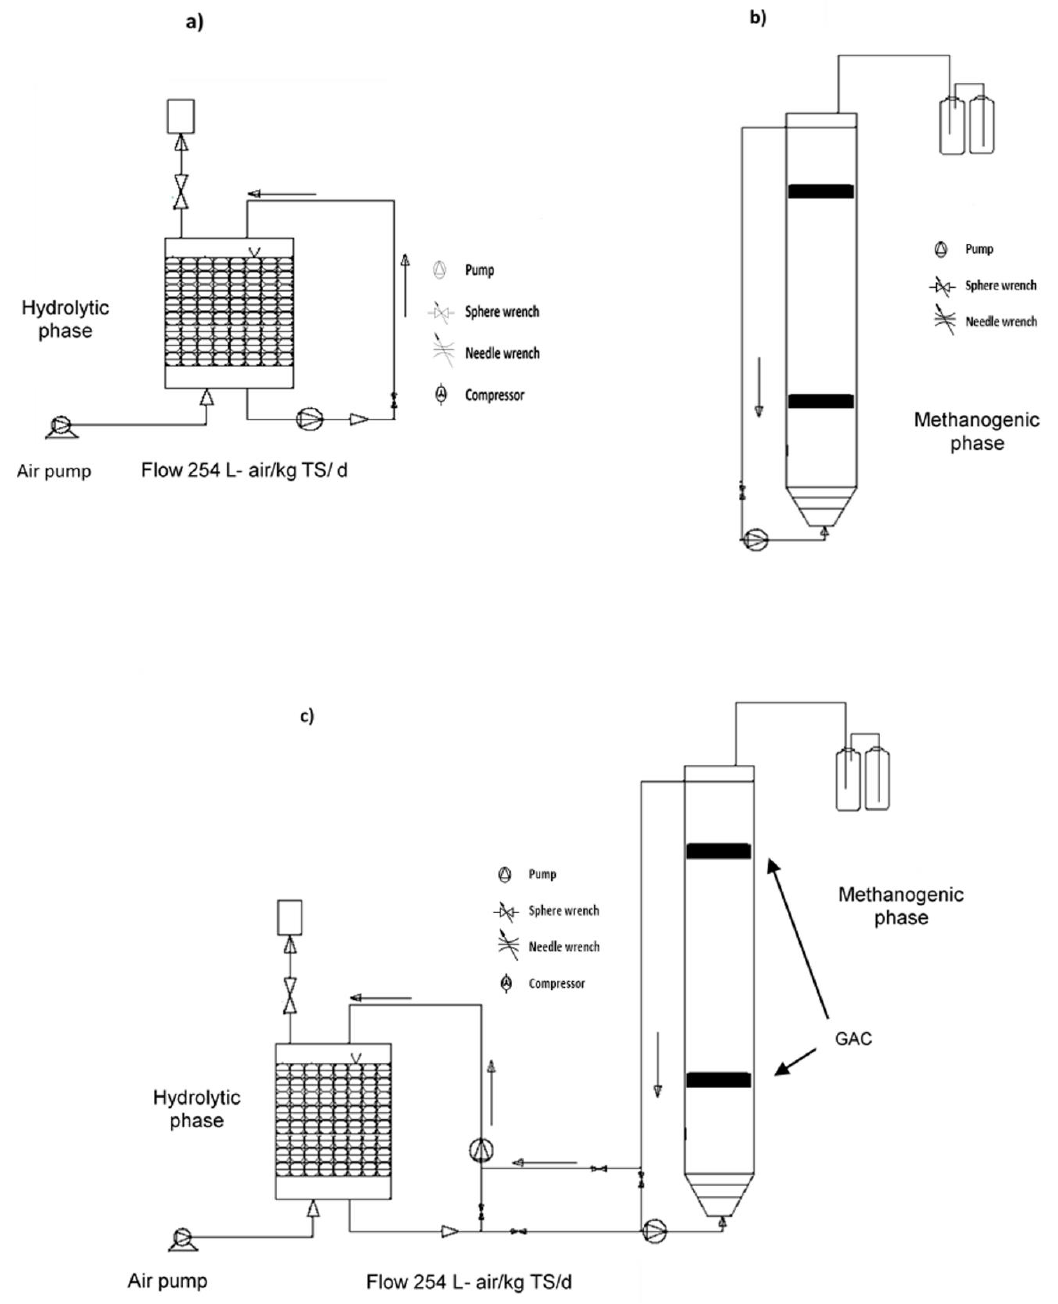
Figure 1. Layout of experiments for the coupling of reactors; ( a ) packed bed reactor with micro-aereation, ( b ) upflow anaerobic sludge blanket, ( c ) Coupling Packed Bed Reactor with micro-aereation and upflow Figure 1. anaerobic sludge blanket with direct interspecies electrons